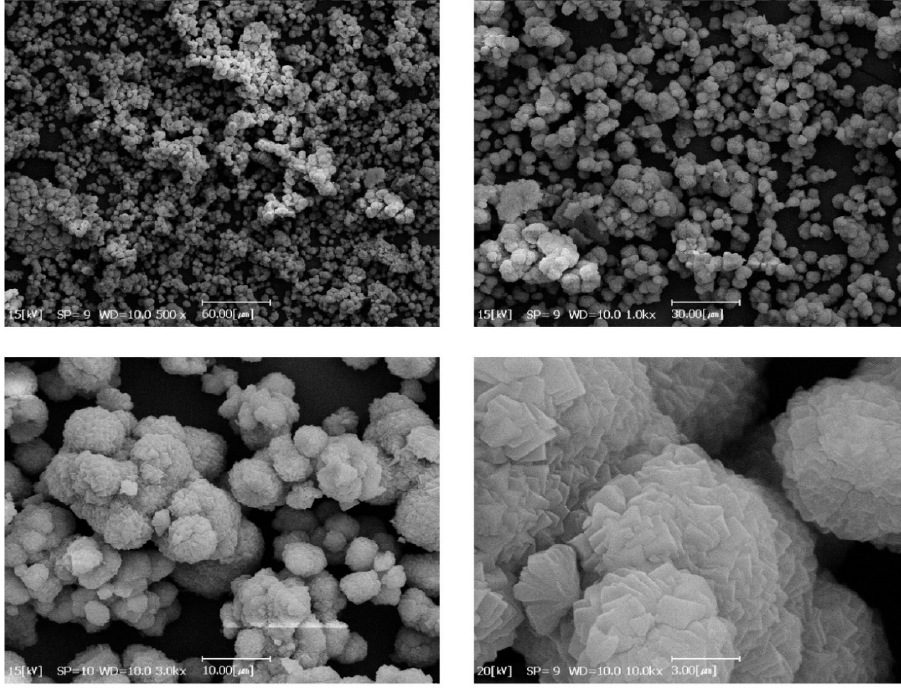
Figure 3. SEM images of synthesized Ni-MOF-74 particles at different magnifications.